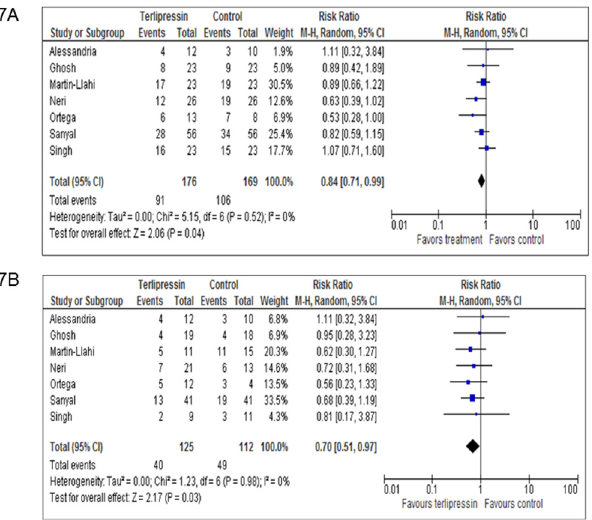
Fig 7. Mortality in Treatment vs Control Group. Forrest plots assessing the relative risk for overall (6a) and post-treatment (6b) mortality between those treated with terlipressin plus albumin vs all other control groups. Post-treatment mortality represents the mortality during the duration of the follow-up period in those who survived the treatment period. Total N therefore reflects those patients who survived the treatment period and “ Events ” are the number of those patients who then subsequently died during follow-up.